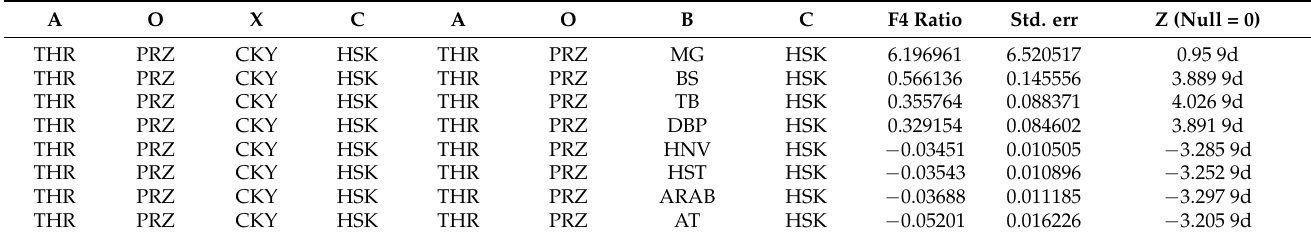
Table 1. Estimation of the genome-wide possible ancestry of the Chakouyi horses *.